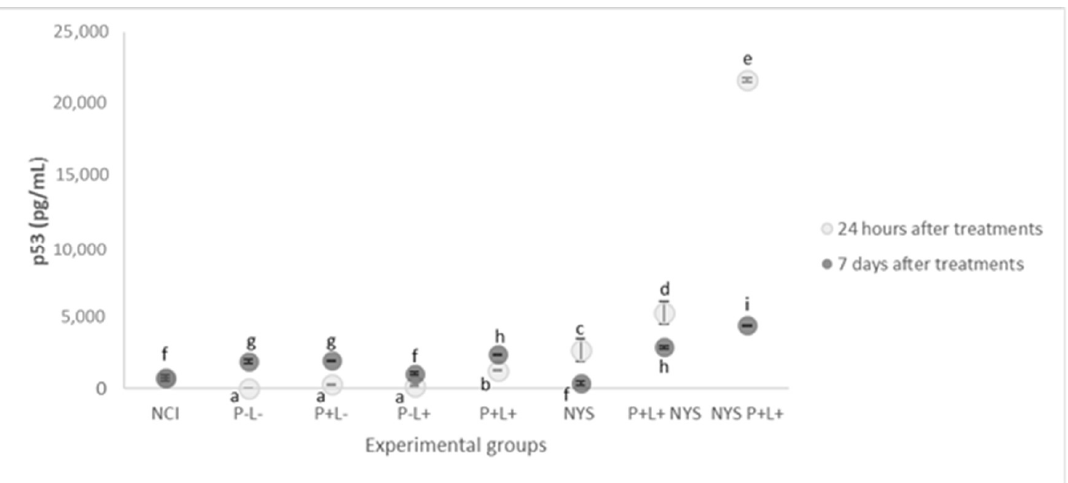
Figure 8. The mean values and standard deviation of the expression of p53 (pg / mL) for all of the evaluated groups. Equal lowercase letters denote a statistical similarity among the experimental groups after 24 h and 7 days of treatment ( p ≥ 0.05).